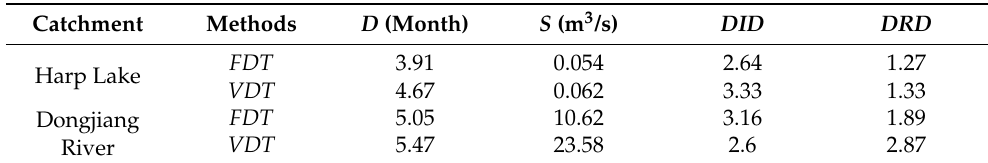
Table 2. Averages for the propagation characteristics of hydrological drought ( HD ) events with a duration longer than 3 months at the HP0 station of Harp Lake and the Lantang station of the Dongjiang River catchment; FDT and VDT represent fixed and variable drought threshold methods, respectively; D and S are the duration and severity of HD ; DID and DRD are the HD intensification and recovery